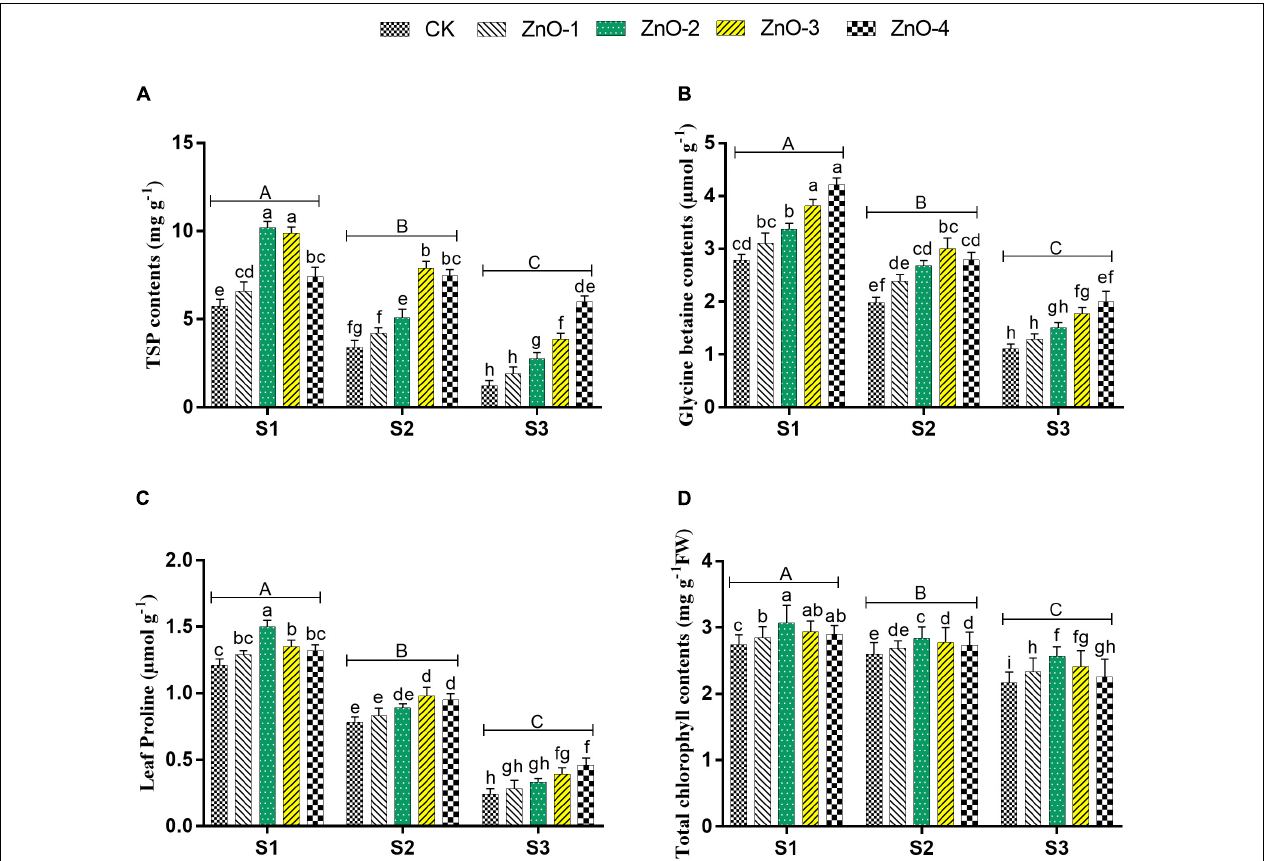
FIGURE 4 | Effect of foliar application of nano-ZnO on total soluble proteins (TSPs) (A) , glycine betaine (B) , leaf proline (C) , and total chlorophyll contents (D) in Vigna radiata L. under sowing time generated heat stress. Nano-ZnO doses: CK (distilled water), ZnO-1 (15 mg l − 1 ), ZnO-2 (30 mg l − 1 ), ZnO-3 (45 mg l − 1 ), and ZnO-4 (60 mg l − 1 ). S1, First sowing-March 1 (recommended); S2, Second sowing-March 22 (late sown); S3, Third sowing-April 11 (late sown). Data are mean ( ± SE) of three replicates and different letters designate significant changes at Tukey’s test ( p < 0.05). In contrast, capital letters represent a significant difference among sowing time treatments and small letters represent a significant difference among the nano-ZnO treatments.